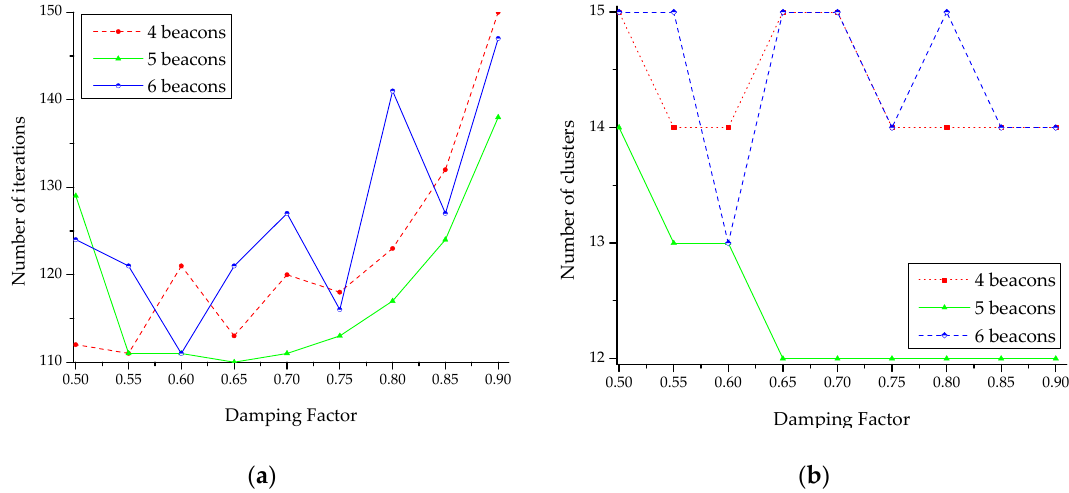
Figure 5. Effect of damping factor ( 𝛾 ) in APC ( a ) the number of clustering operation iterations, ( b ) the number of clusters with respect to the damping factor.